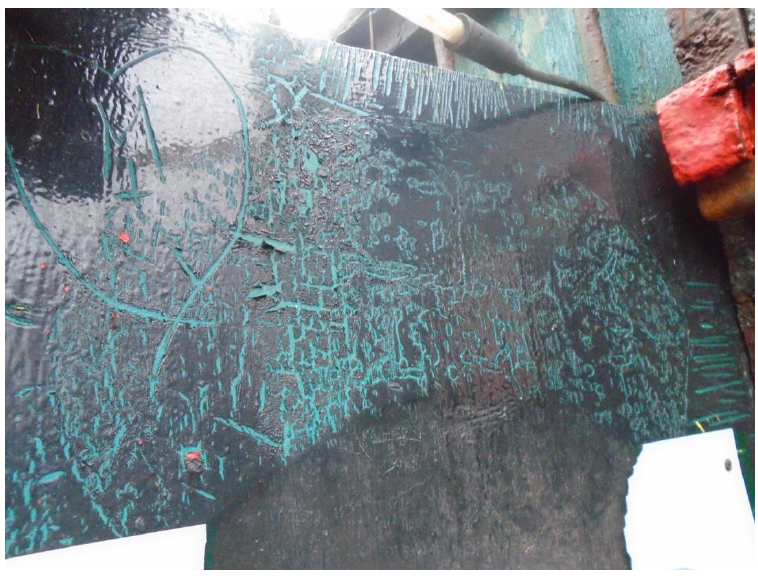
Figure 21. Perished paint.